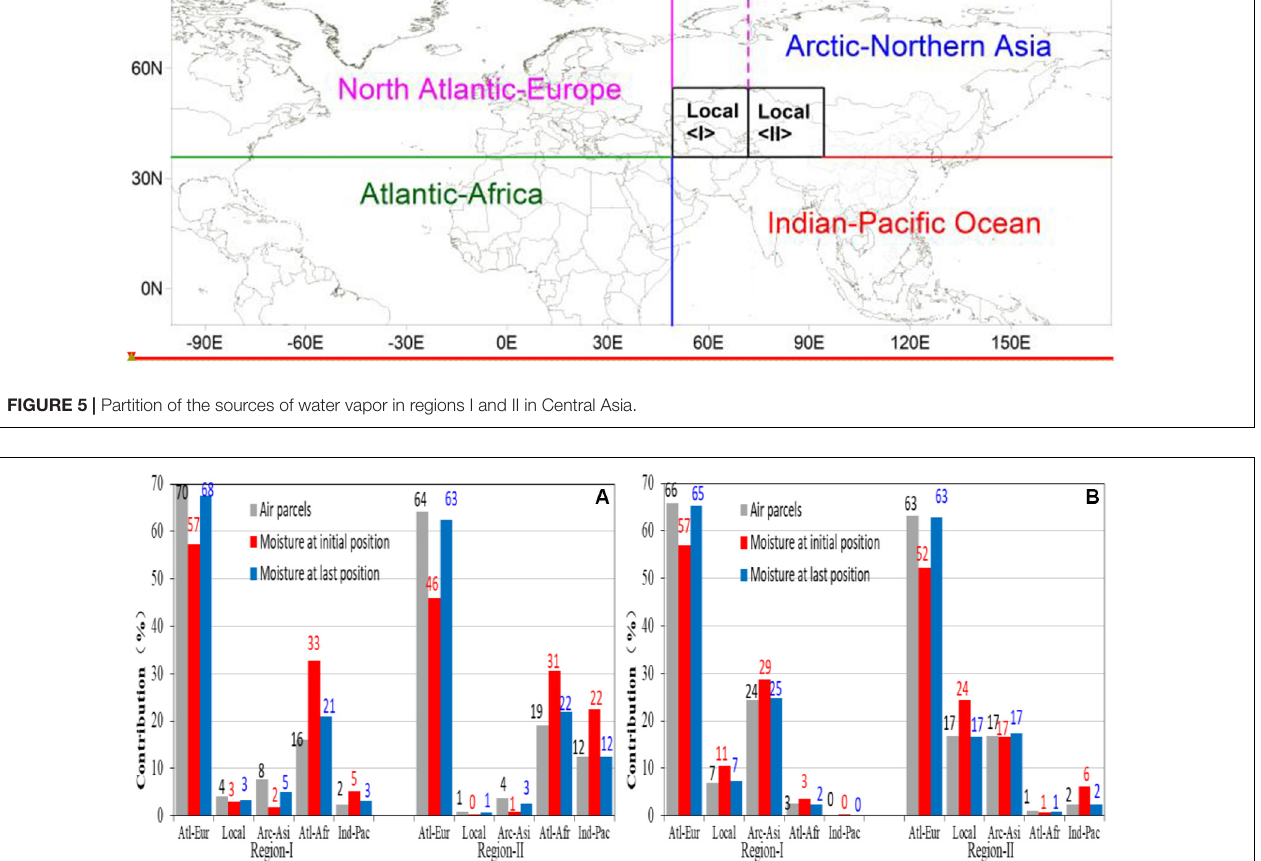
FIGURE 6 | Contribution of air parcels and moisture at the initial and final positions from various regions in (A) winter and (B) summer during